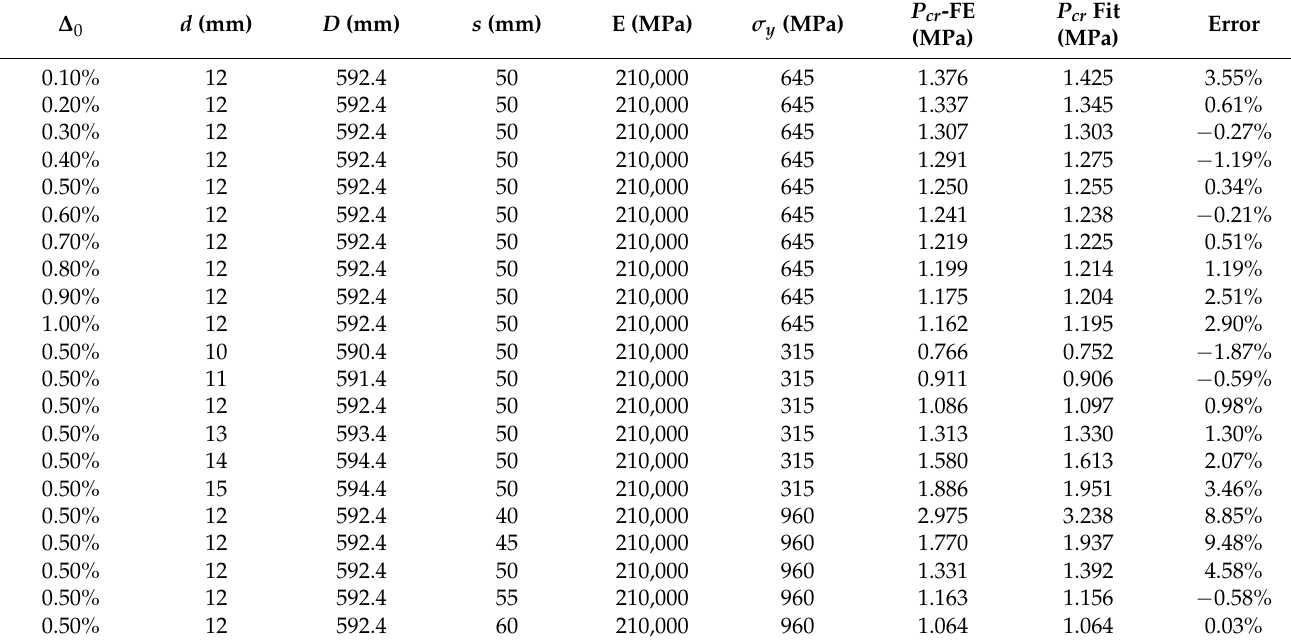
Table 5. FEM results compared with predictions from Equation (7).